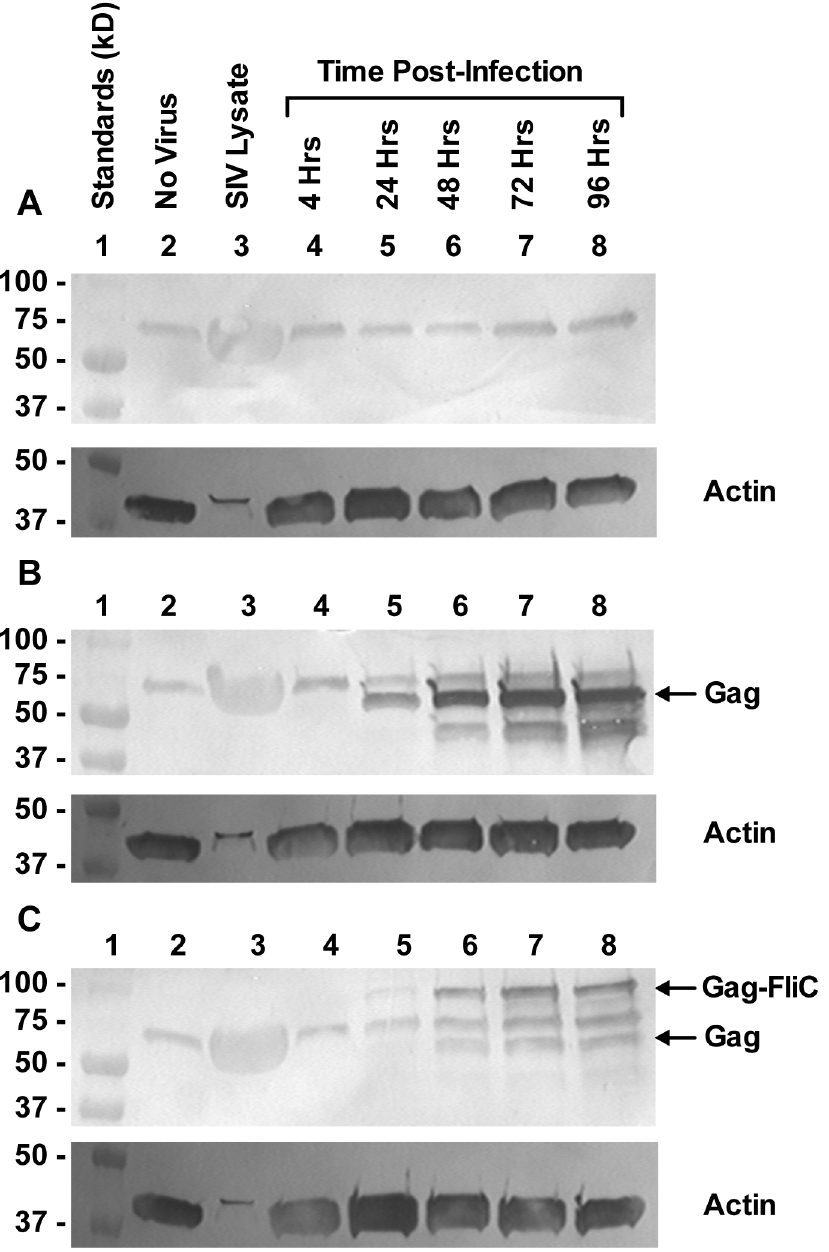
Fig 7. RhCMV gagfliC Δ 196 – 378 expresses an SIV Gag-FliC Δ 196 – 378 fusion protein. Western blot analysis of samples collected at the indicated times post-infection from TeloRF cells infected with either (A) RhCMV, (B) RhCMV gag , or (C) RhCMV gagfliC Δ 196 – 378 were tested for reactivity with Gag p27 and actin (loading control) monoclonal antibodies. BioRad Precision Plus Protein Dual Color Standards indicate molecular weights (Lane 1). Lysates generated from TeloRF cells (No Virus; Lane 2) indicate background reactivity with the p27 antibody. Lysates of tissue culture supernatant collected from CEMx174 cells infected with SIVmac239 were used as positive controls for detection of SIV Gag (Lane